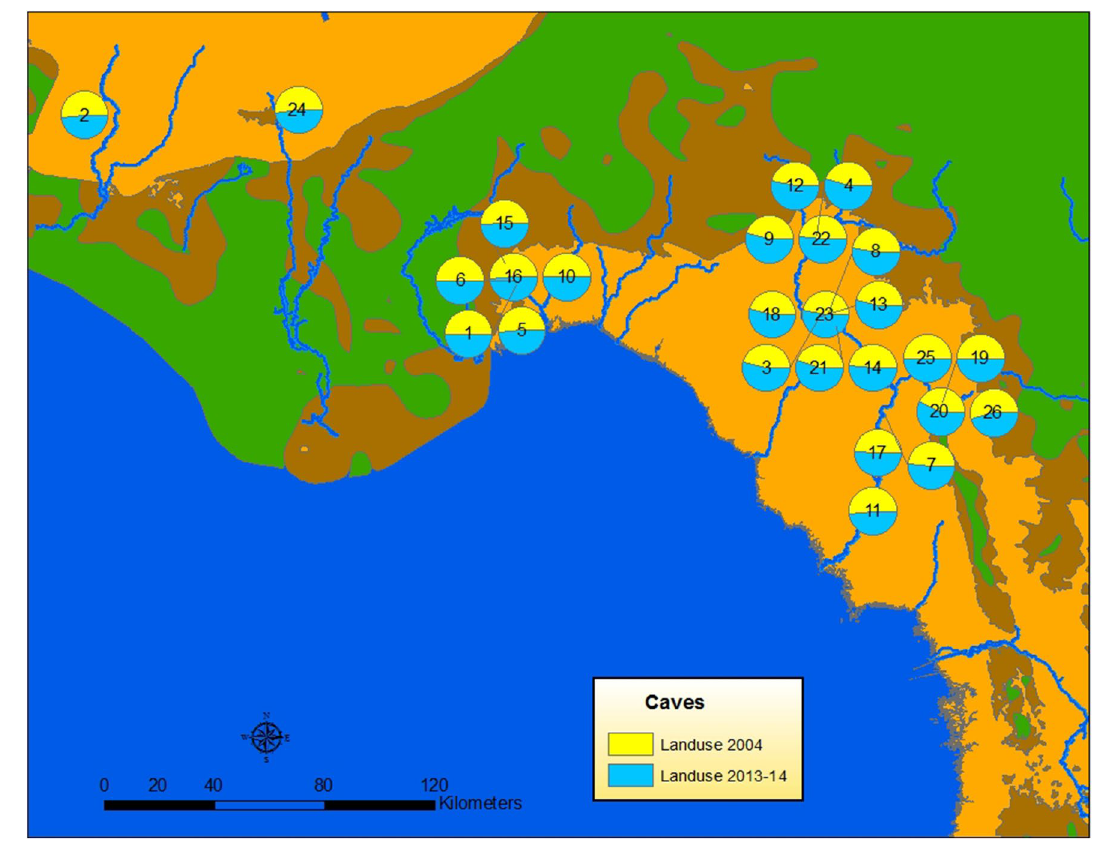
Fig. 7 Nitrate-producing land use changes around caves/springs